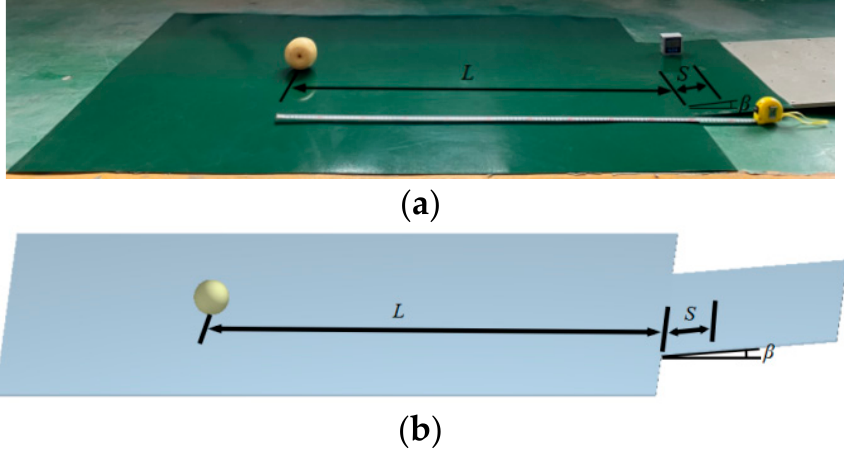
Figure 6. Calibration experiment of rolling friction coefficient between pears and materials. Physical experiment ( a ); Simulation experiment ( b ).